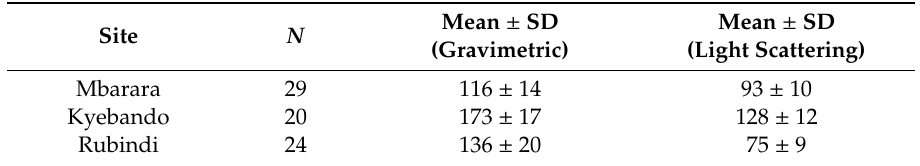
Table 3. Comparison of PM 10 levels ( µ g · m − 3 ) measured at three di ff erent locations using gravimetric and light-scattering techniques. N is the number of samples for which both sets of data were available and SD is the standard deviation of the mean. Mean ± Site N